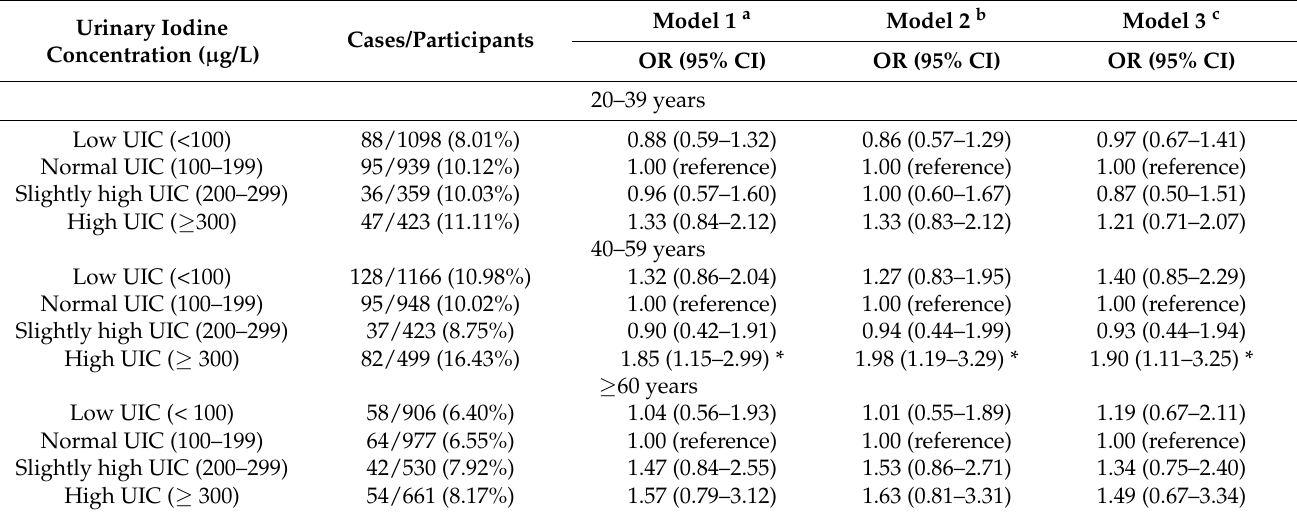
Table 4. Weighted ORs and 95% CIs of depressive symptoms stratified by age.